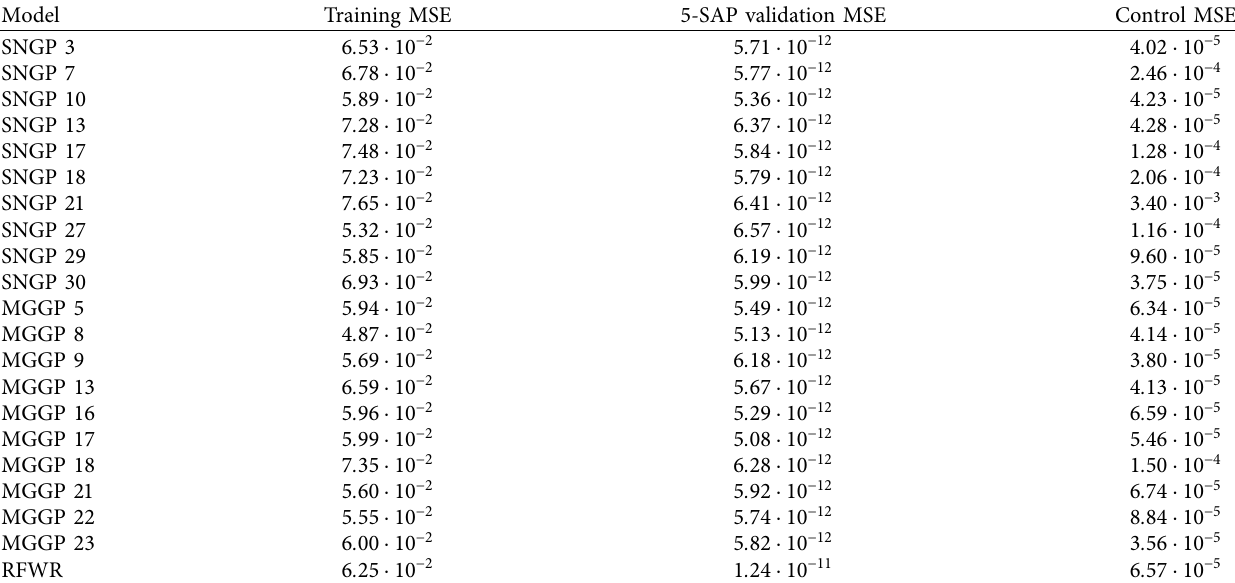
Figure 4: Random input signal (generalized binary noise with random coil switching) with only one coil active at a time for training and validation sets generation. Table 2: Statistical results of the best